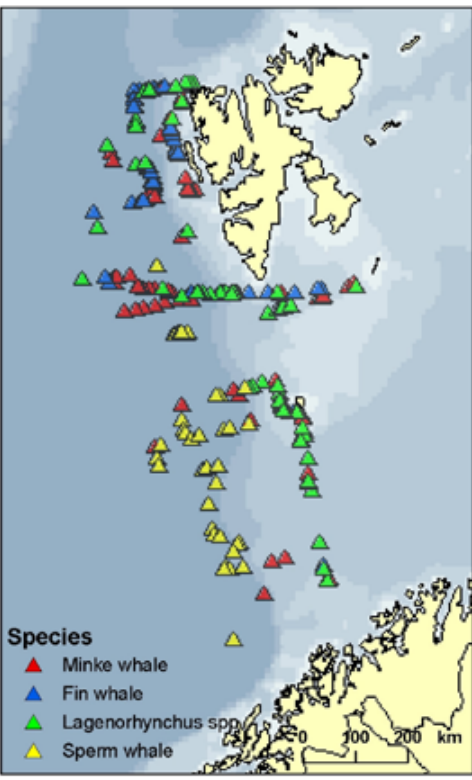
Fig. 8. Distribution of minke whales in 2000, 2001 and